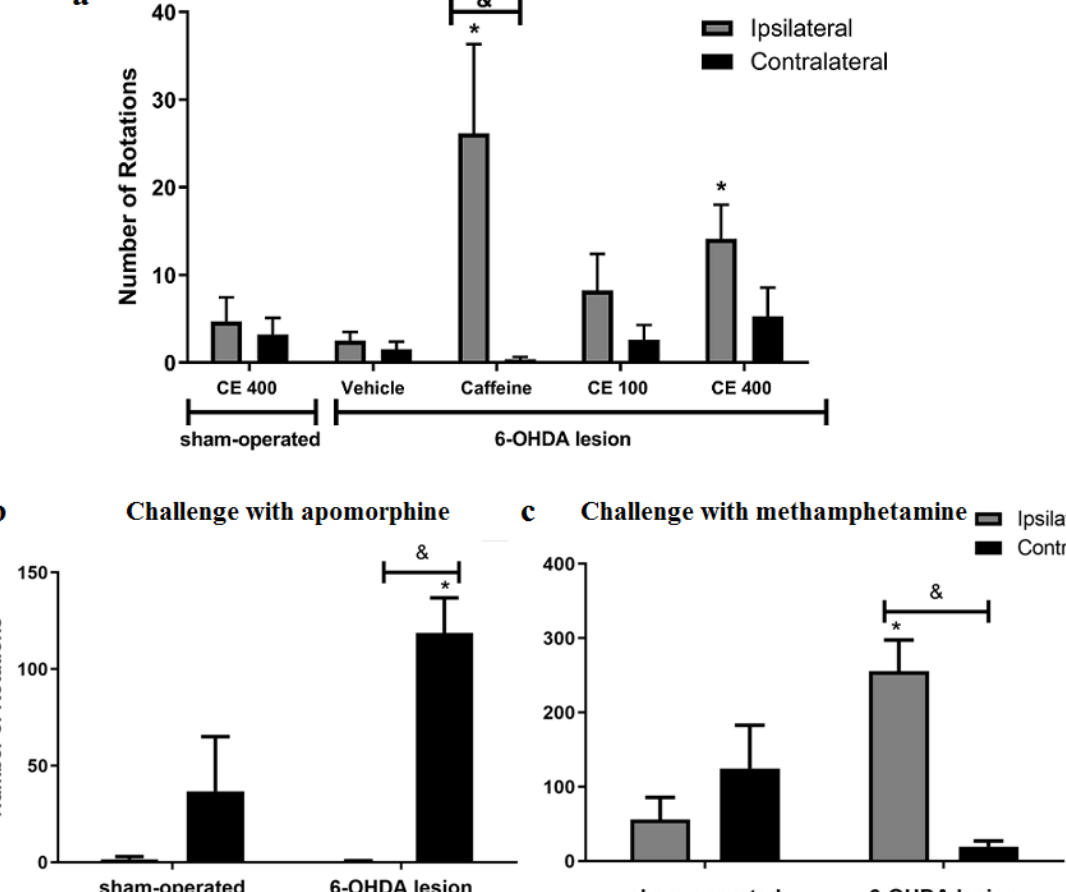
Figure 3. Caffeine, CE (400 mg/kg), and methamphetamine induce ipsilateral rotations, and apomorphine induces contralateral rotations in rats with 6-OHDA unilateral lesion of medial forebrain bundle (MFB). a) 14 th day challenged with coffee extract (CE 100 or 400 mg/kg, po), caffeine (31.2 mg/kg, po) or vehicle. b) 15 th day challenged with apomorphine (0.1 mg/kg, sc). c) 16 th day challenged with methamphetamine (2.5 mg/kg, ip). Data are expressed as mean ± standard error of mean, n=10-15. * p <0.05 statistically different from vehicle (Kruskall- Wallis/Mann-Whitney, panel a) or sham-operated group (Mann-Whitney, panels b and c); & p <0.05 statistically different when comparing ipsilateral vs contralateral (intra-group comparison,